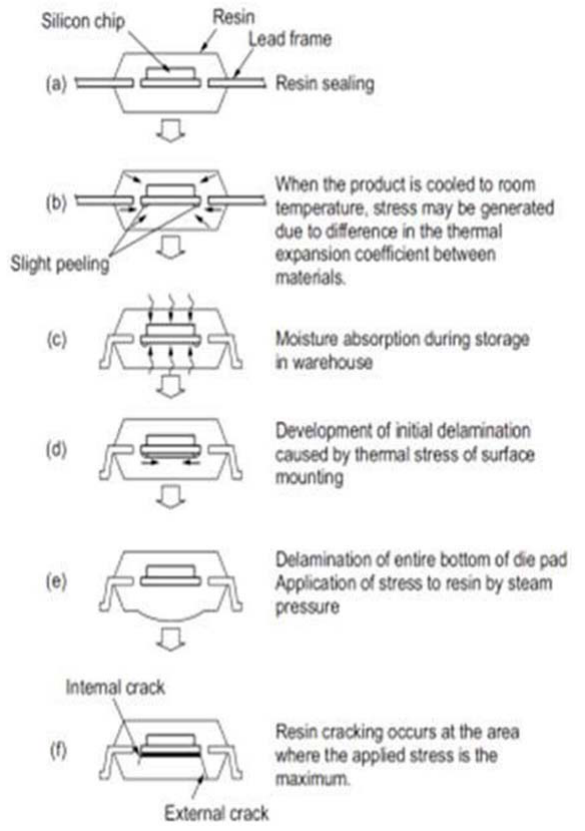
Figure 9. Mechanism of package cracking